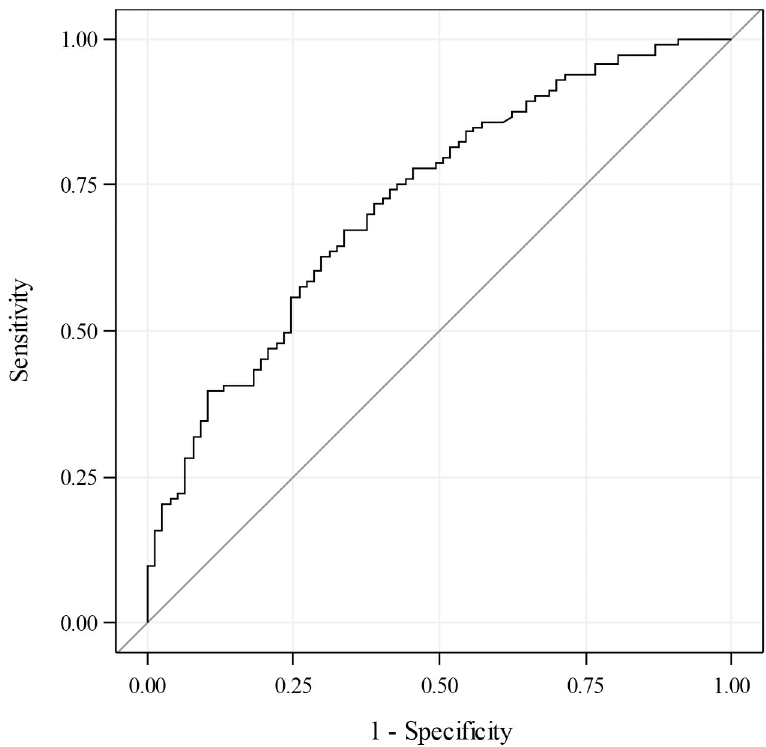
Fig 3. A receiver-operating characteristic curve model depicting sensitivity by 1-specificity for non- remission as predicted by bicarbonate < 15 mg/dL, age < 5y, female sex, and > 3 diabetes-associated autoantibodies. The area under the curve is